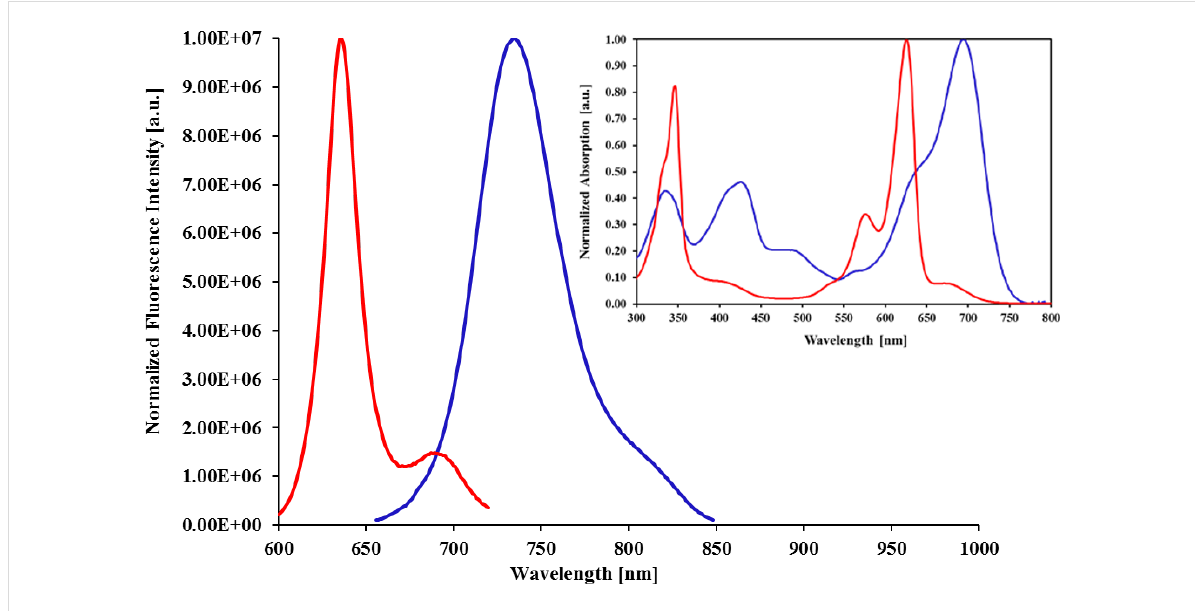
Figure 1: Emission spectra of BODIPY 3 (blue line: Excitation at 680 nm; emission at 737 nm) and BODIPY 4 (red line: Excitation at 600 nm; emis- sion at 637 nm). Inset: absorption spectra of BODIPY 3 (blue line) and BODIPY 4 (red line) (solvent: chloroform). BODIPY 4 was protonated upon ad- dition of H + in the